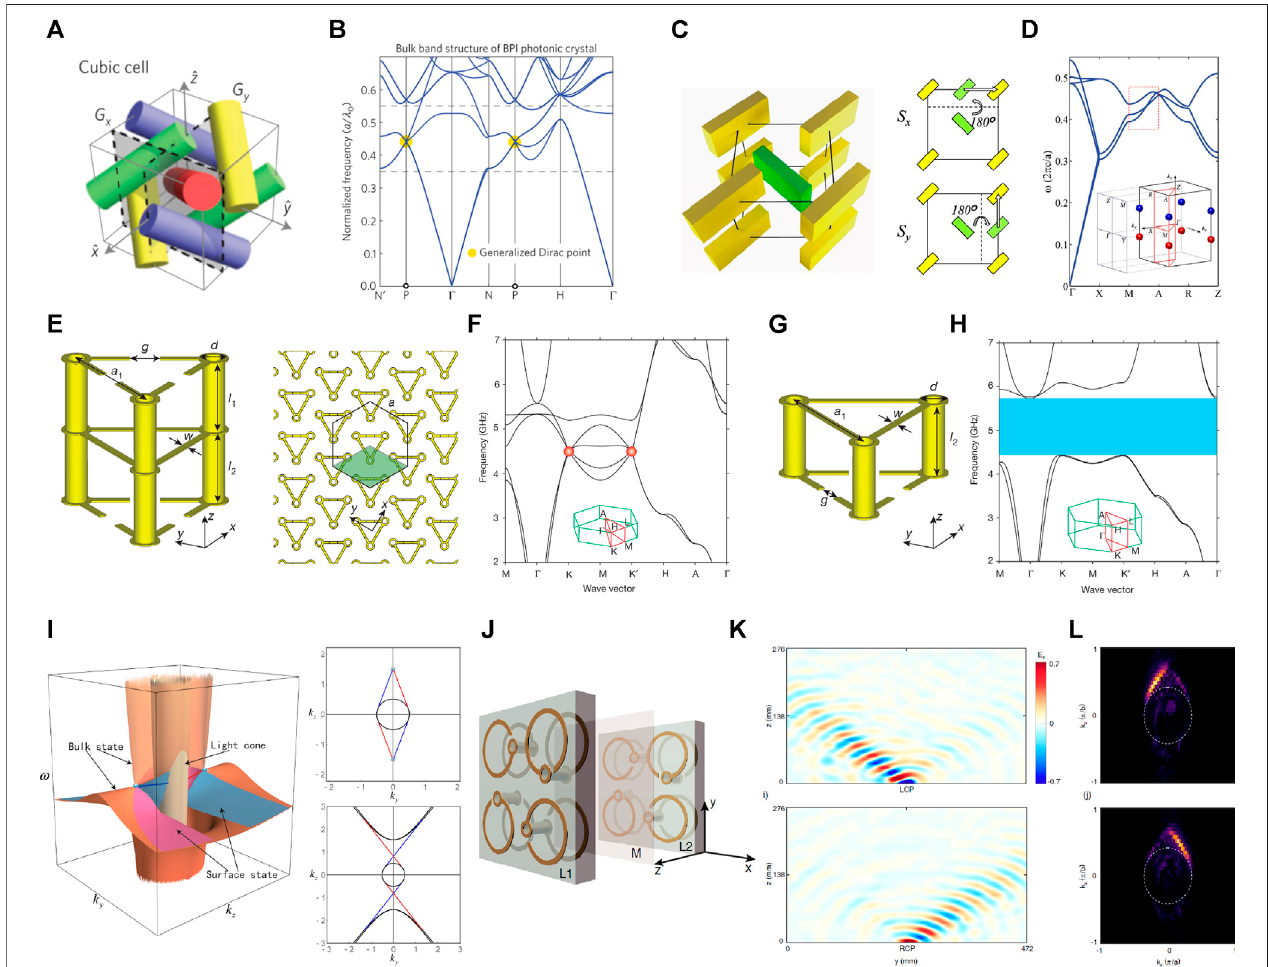
FIGURE 4 | (A) Photonic crystal with glide re fl ection in x , y , and z directions [74]. (B) Band structure with a single 3D Dirac point. (C) 3D Dirac photonic crystal with screwsymmetriesand (D) itsphotonicbandstructure[78]. (E) 3Darrayofmetallicsplit-ringresonatorswith3DDiracpoint[79]. (F) Bandstructureofthephotoniccrystal with the unit cells in (E) . (G) Unit cell giving rise to a 3D topological bandgap through removing the top three split-ring resonators. (H) Band structure of the photonic topological insulator with the unit cells in (G) . (I) Bulk and surface state dispersions of a Dirac metamaterial with electromagnetic duality symmetry [81]. Equifrequencycontouratabove (top-right) andbelow (bottom-right) theDiracpointfrequency. (J) Printedcircuitboardunitcellandspin-polarizedtopologicalsurface states of a Dirac metamaterial (K) in the real and (L) momentum space [82].